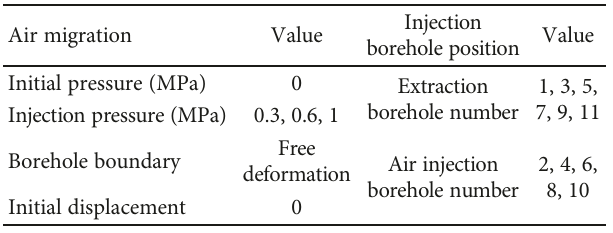
Figure 9: Setting of numerical model for methane extraction under air injection. Table 3: Air migration equation setting.